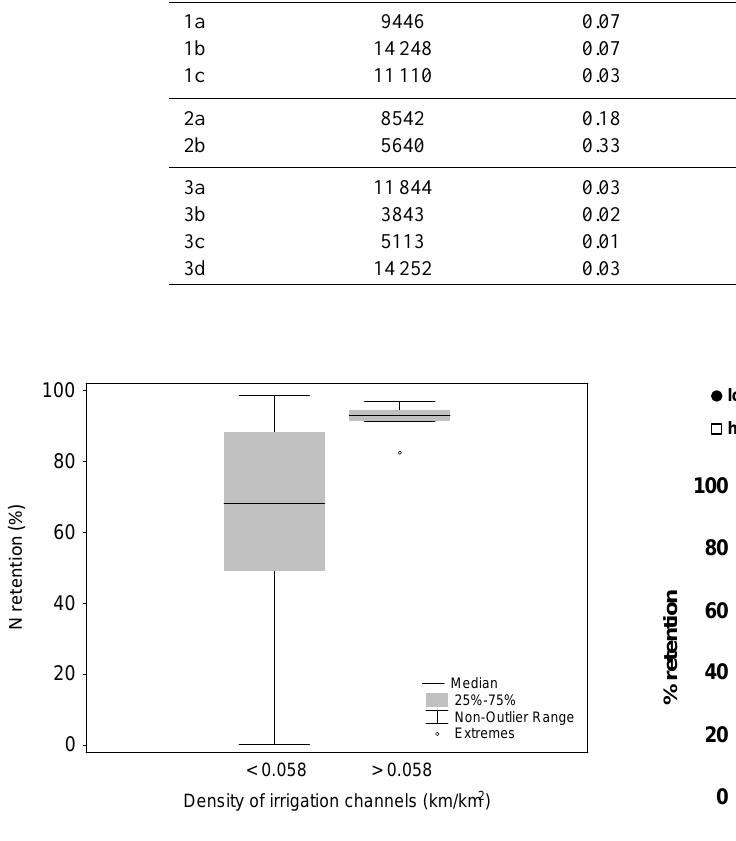
Figure 6 Distribution of N retention in slightly and highly channelized sub-catchments. Fig. 6. Distribution of N retention in slightly and highly channelized sub-catchments.